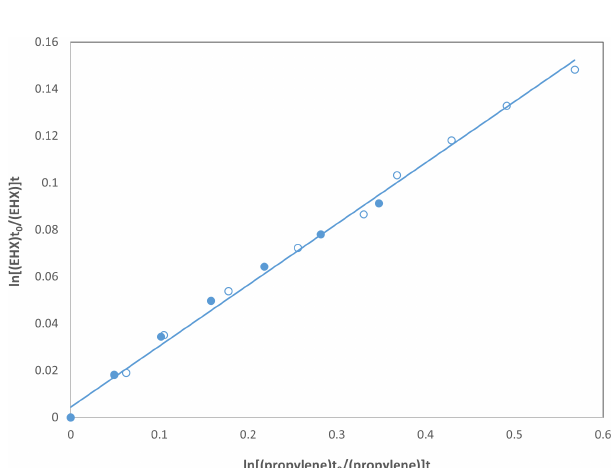
Figure 2. Kinetic data for the reaction of OH radicals with EHX using propylene as reference compound performed in the 480L re- actor ( • ) and the 1080L reactor ( ◦